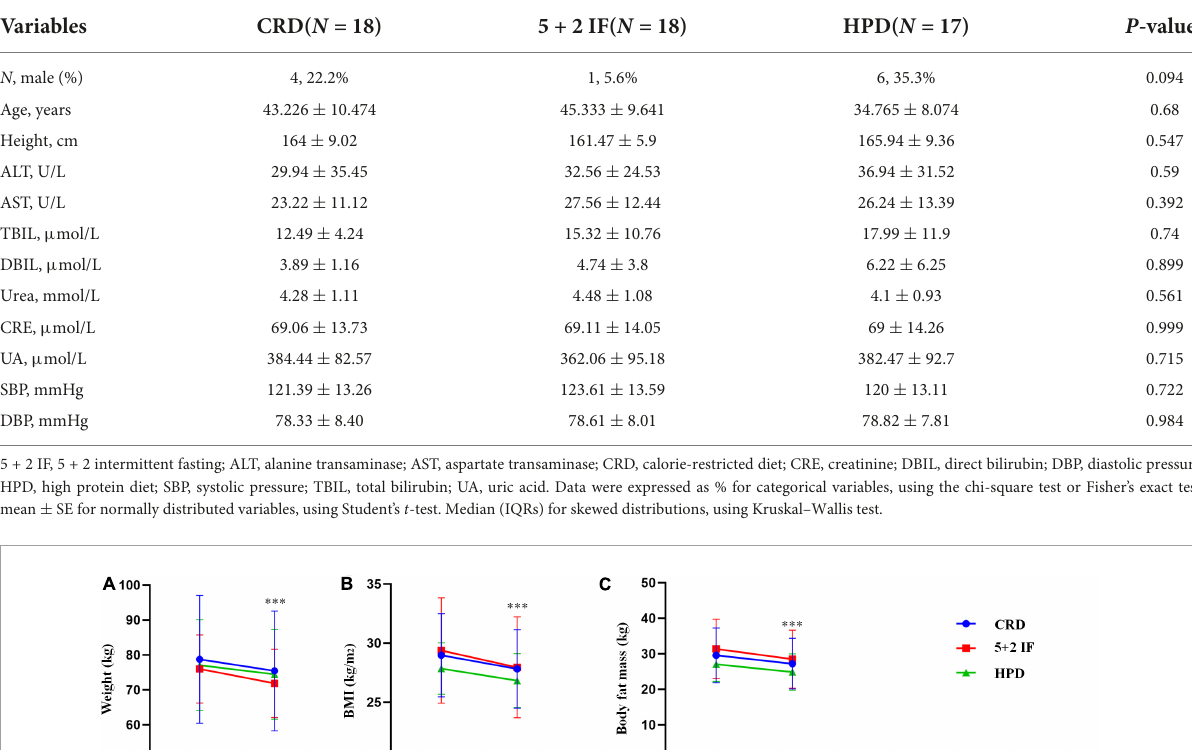
TABLE 1 Baseline characteristics of the study population.